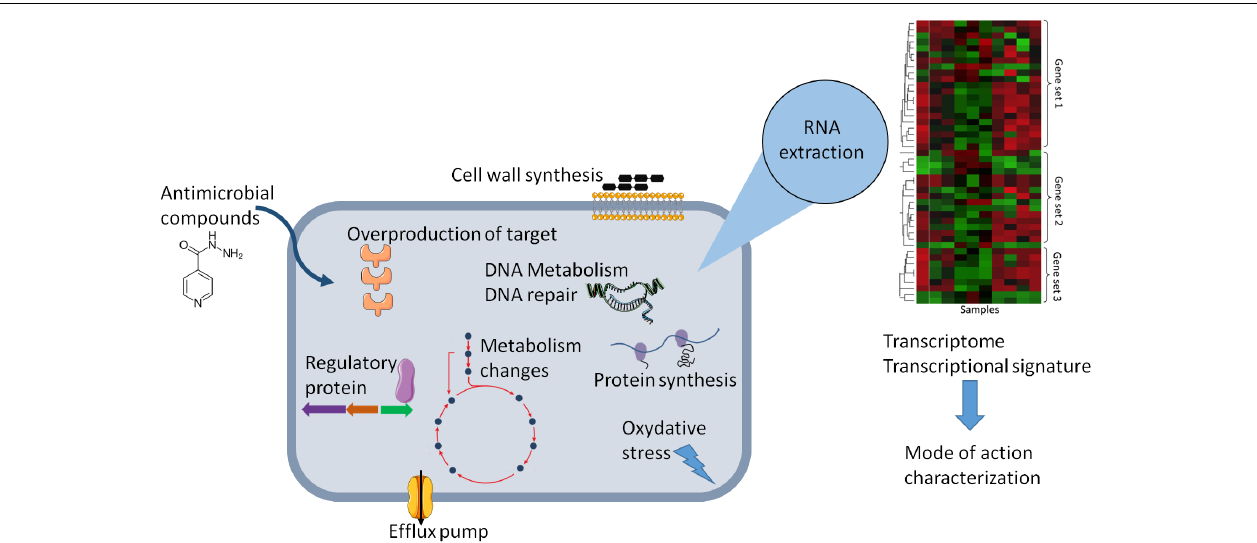
FIGURE 1 | Schematic representation of the effect of antibiotic on the physiology of bacteria that can be explored by change in gene expression. Gene expression dynamic can reflect cellular response in the presence of antibiotic and can lead altered cellular state or adaptive responses and antibiotic tolerance. The transcriptional signature analysis allows to have new insights in the molecular mechanism of antimicrobial compounds or to predict the mode of action of uncharacterized antimicrobial